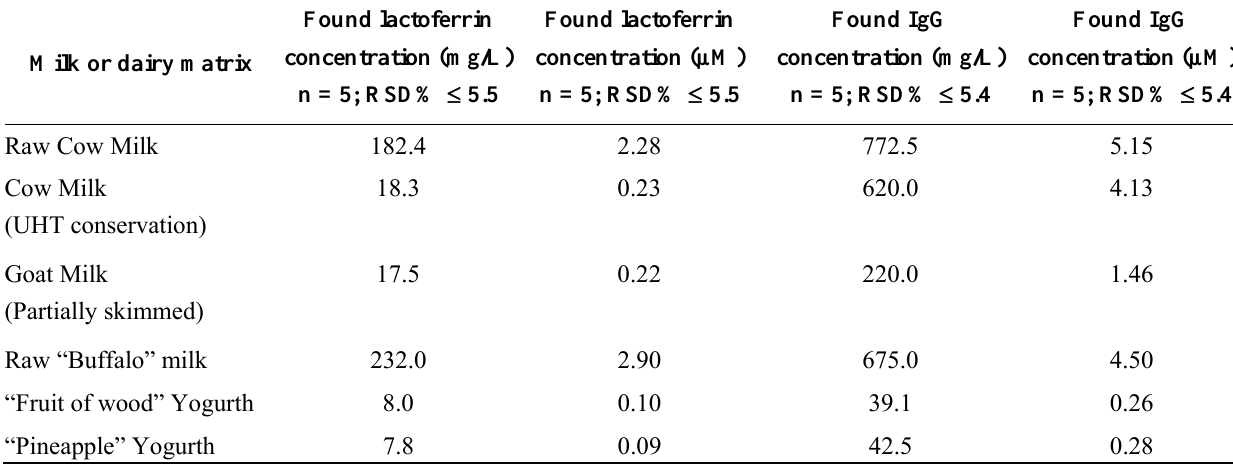
Table 2. Determination by immunobiosensor of lactoferrin and IgG concentration values in cow, goat and buffalo milk and in two dairy milk products (yoghurt). Values expressed both as mg/L and as µM.